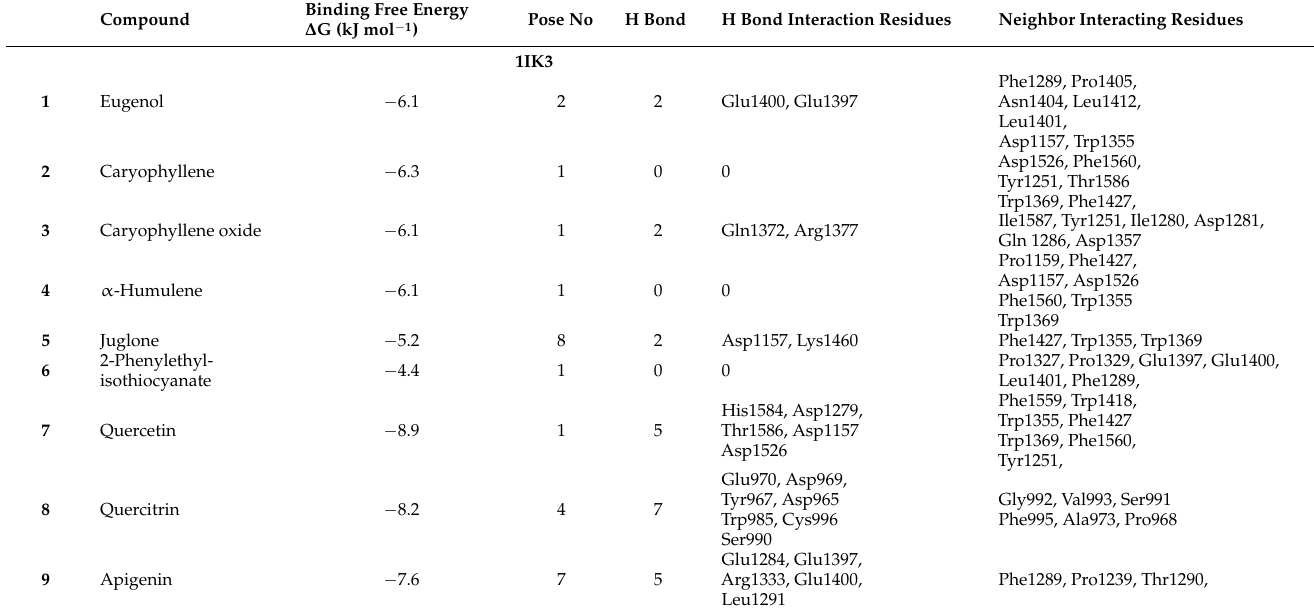
Table 2. Docking score, H- and non-H bonding interactions of test compounds for transcriptional regulator 1IK3 (15-lipoxygenase).